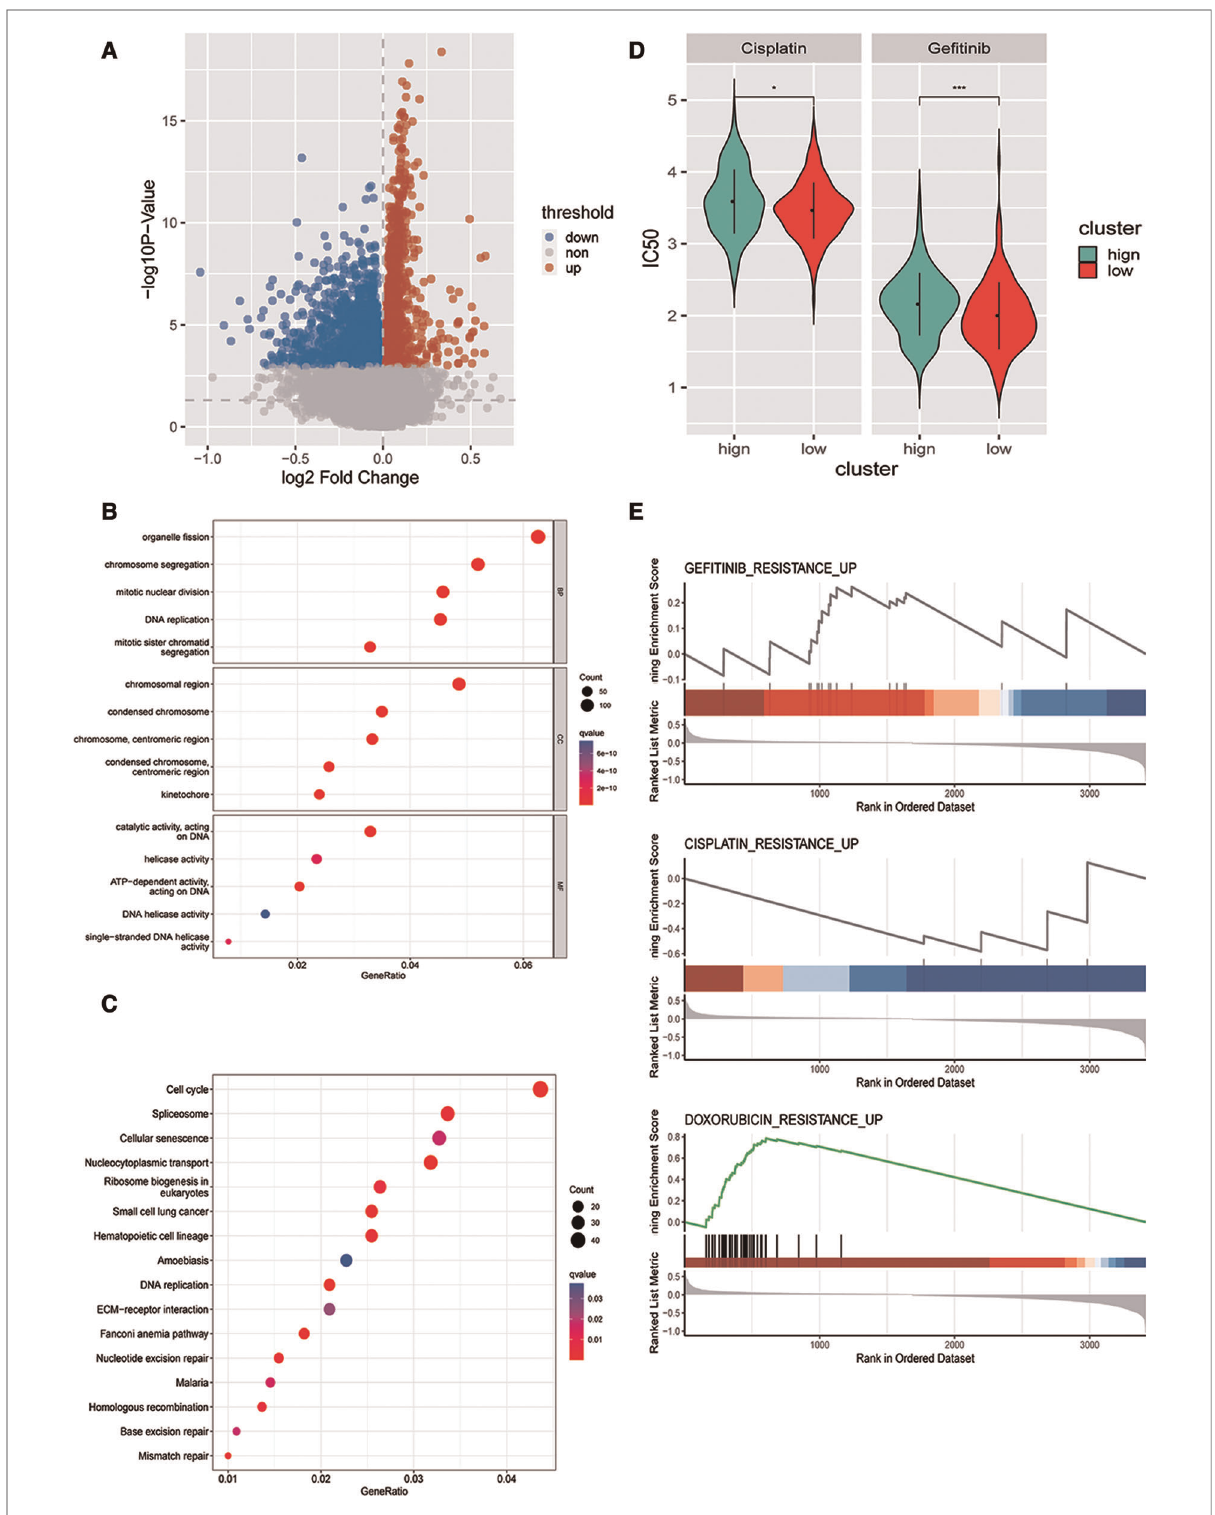
FIGURE 6 Evaluation of the association between the risk model and chemotherapy response. ( A ) Volcano map of DEGs in high- and low-risk groups in the training dataset. Gene Ontology analysis ( B ) and Kyoto Encyclopedia of Genes and Genomes pathway enrichment analysis ( C ) of DEGs in two risk groups in the training dataset. ( D ) Predicted differences in drug sensitivity between high- and low-risk groups. ( E ) GSEA analysis of differential genes in drug resistance pathways between high- and low-risk